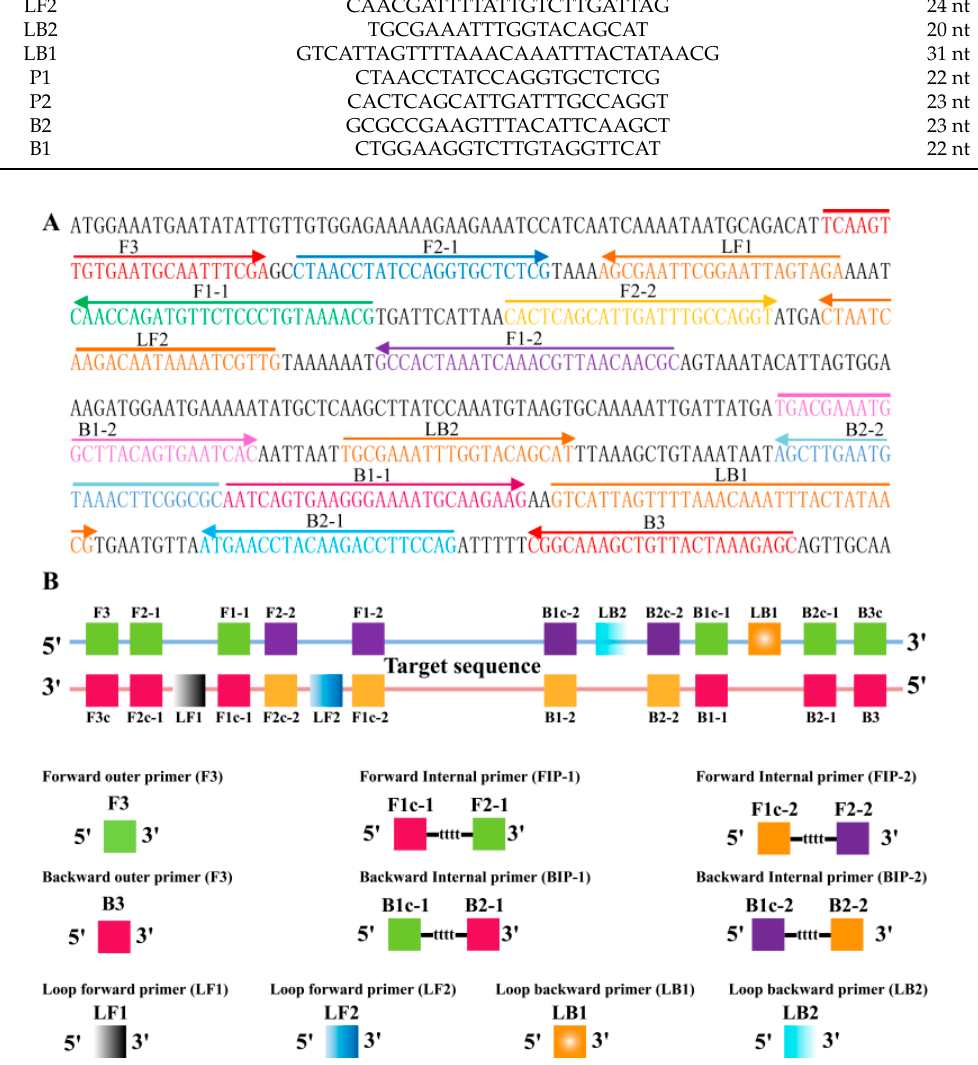
Figure 2. Primers design of MIP-LAMP. ( A ), location and orientation of L. monocytogenes specific MIP-LAMP primers within the nucleotide sequence of the listeriolysin O ( hlyA ) gene (GenBank accession number M24199). The nucleotide sequences of the primer sites are underlined, left and right arrows indicate complementary and sense sequences that are used; ( B ), diagram exhibiting the positions at which the primers attach to amplify the target sequence.